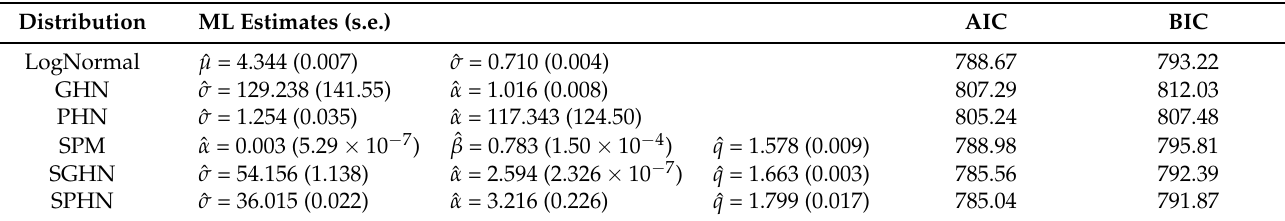
Table 9. Estimated values, SE and information criteria.